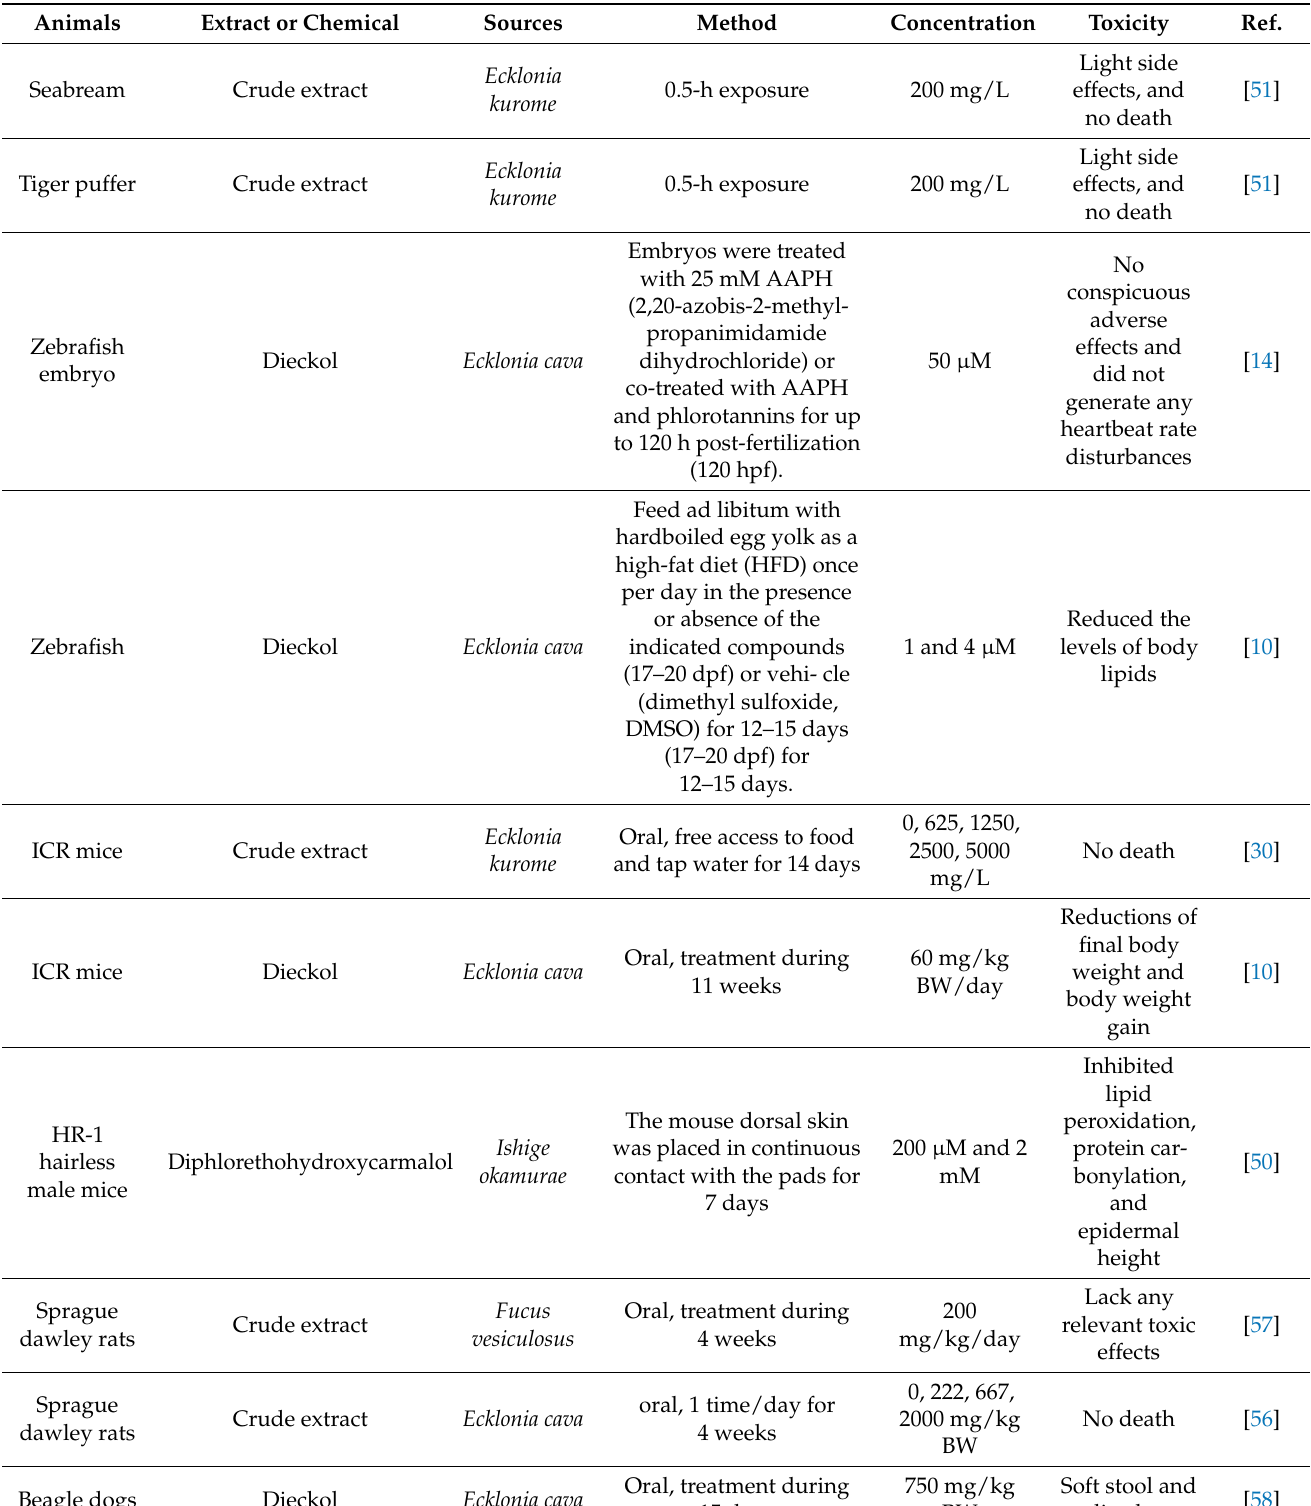
Table 5. Studies of safety and toxicity of phlorotannins extracted from brown seaweeds, as measured in animals.